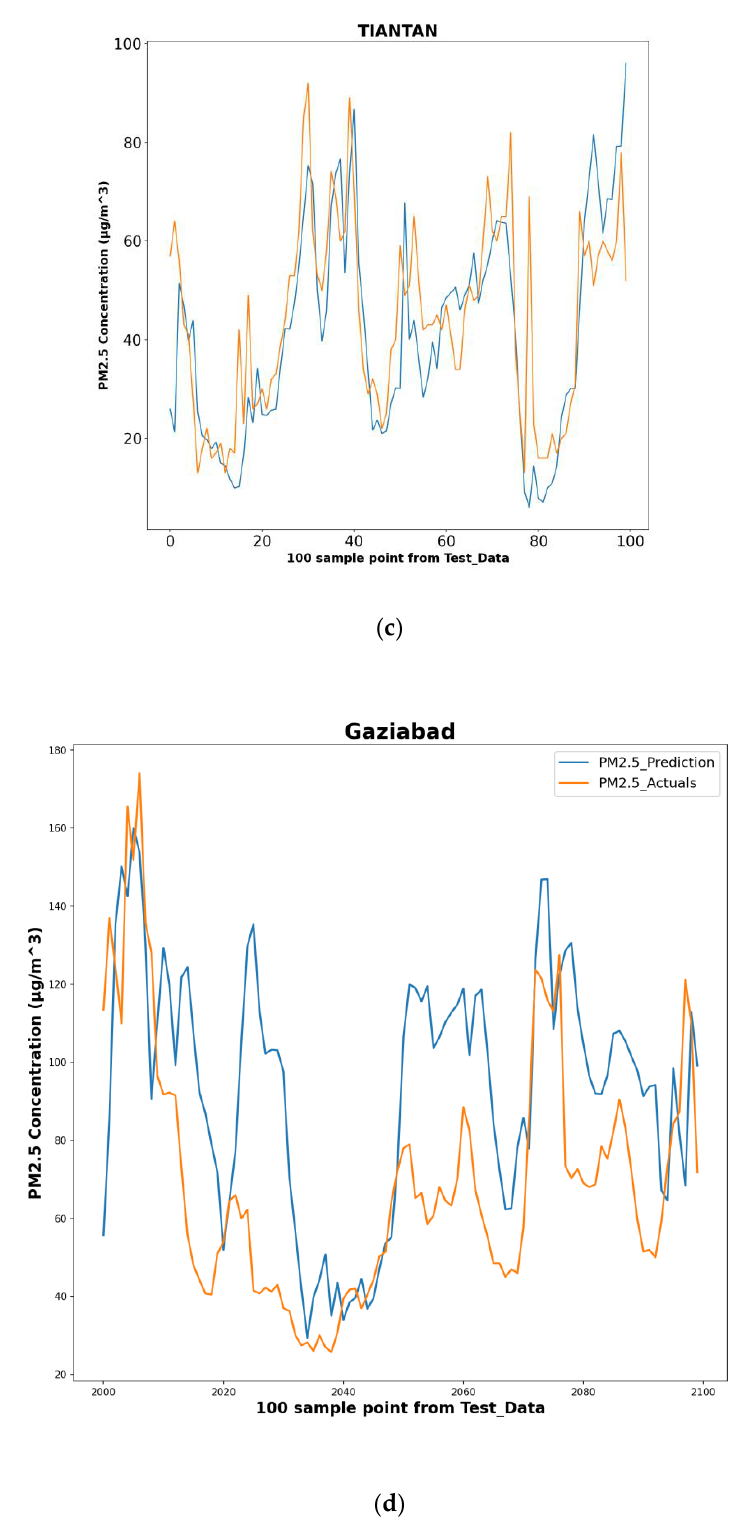
Figure 6. ( a – d ): Graph of actual versus predicted concentration of PM 2.5 pollutant from sample of 100 points for each location.